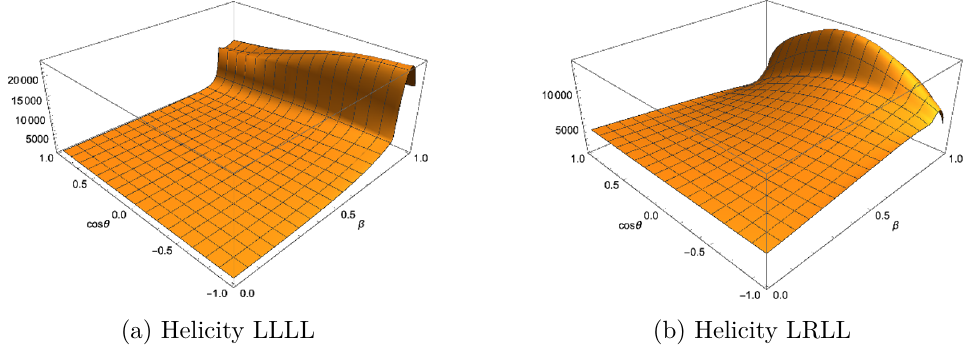
Figure 8. Absolute value of the vector-vector plus axial-axial part of the one-loop helicity ampli-